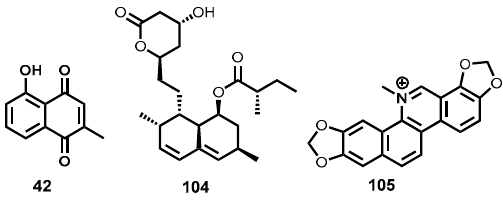
Figure 19. Structures of Mevinolin (lovastatin), plumbagin and sanguinarine.